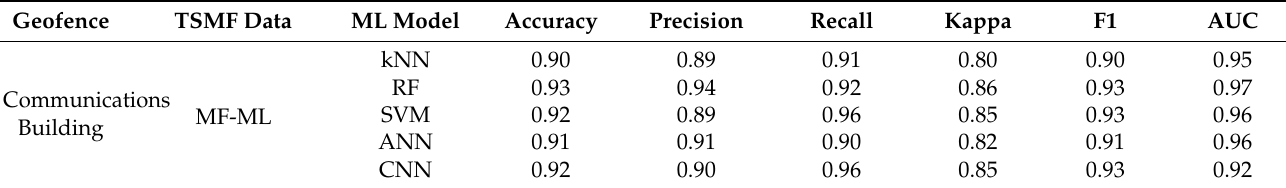
Table 3. Communications department building outdoor MF-ML results.